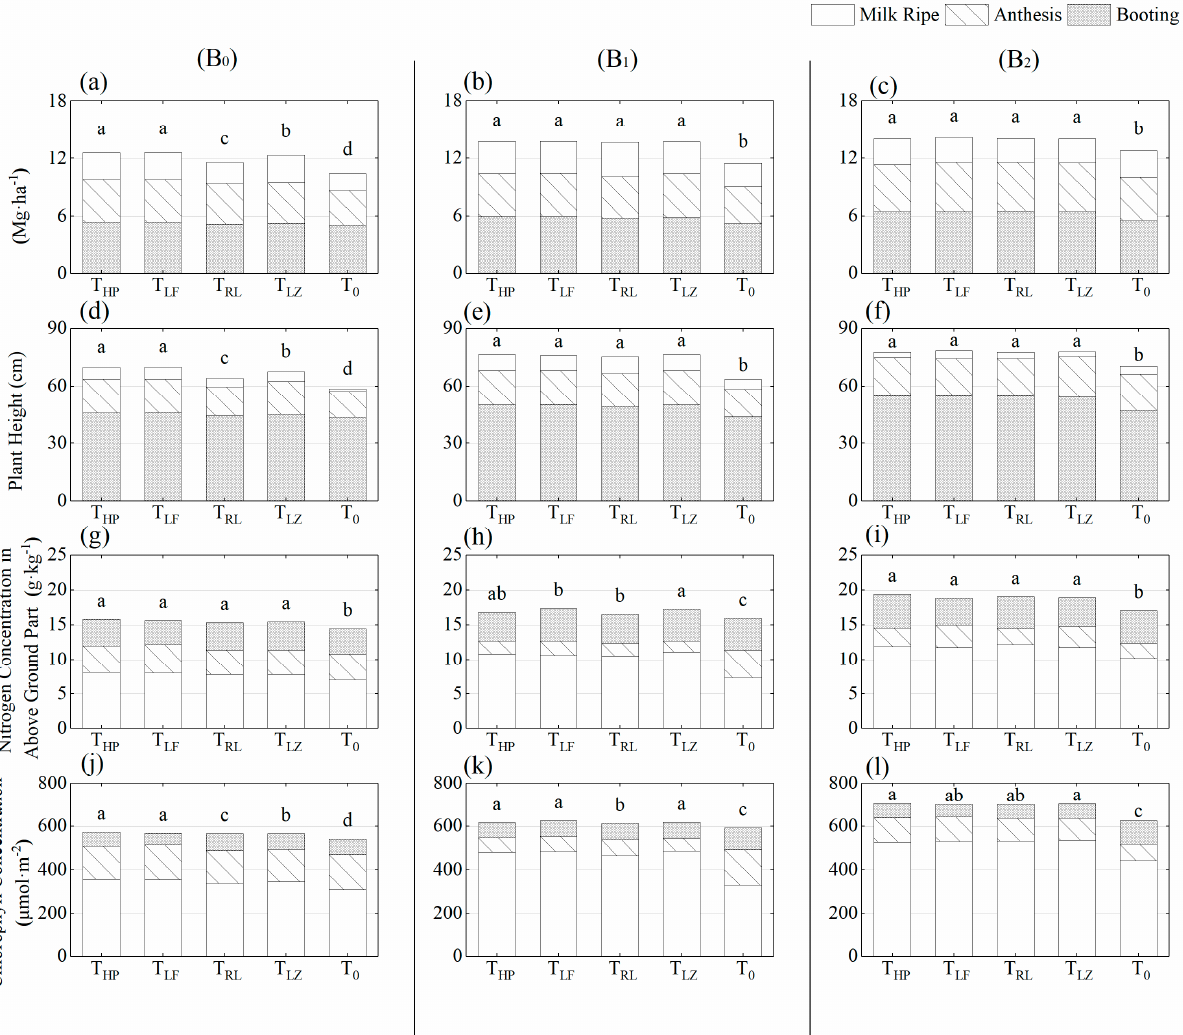
Figure 8. Growing status of winter wheat after topdressing. ( a – c ) Cumulative graphs of above ground biomass. ( d – f ) Cumulative graphs of plant height. ( g – i ) Decreasing graphs of nitrogen concentration in above ground part. ( j – l ) Decreasing graphs of chlorophyll concentration. (B 0 , B 1 and B 2 represent basal fertilizer levels of 0, 57 and 114 kg · N · ha − 1 , respectively; T HP , T LF , T RL , T LZ , and T 0 represent different topdressing methods; different letters indicate significance using Fischer’s protected least significant difference at p < 0.05 at the milk ripe stage).